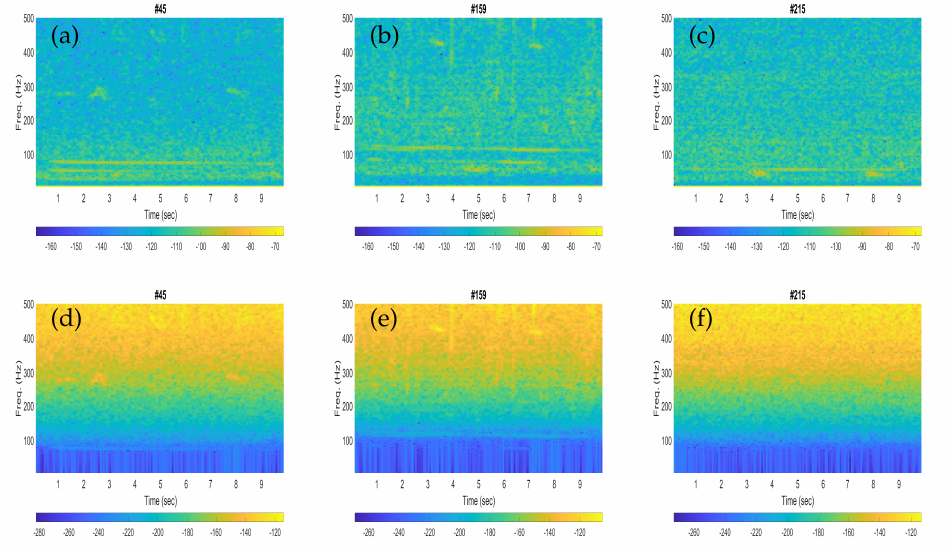
Figure 2. Illustrative spectrogram plots for the noisy signals with blue whale calls ( a – c ) and the corresponding noise-only signals ( d – f